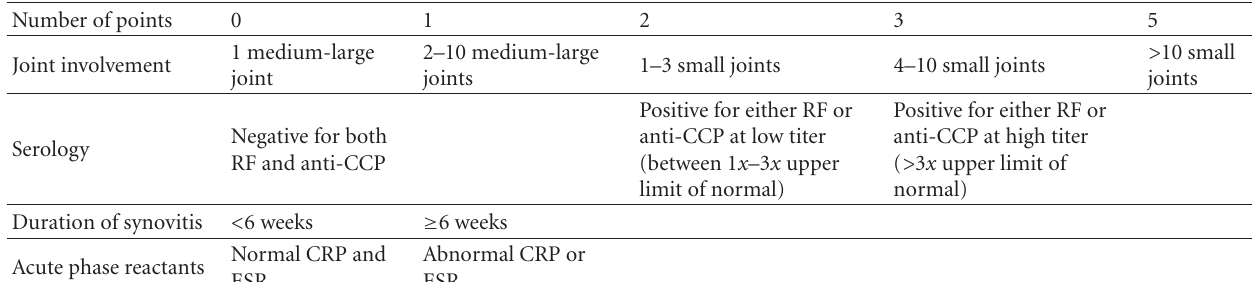
Table 3: 2010 ACR/EULAR scoring criteria for RA. The following table provides the scoring criteria for di ff erent domains of evaluation. For each cell in the table for which the patient satisfies the condition, the cell is scored by the number of points at the top of the column in which it is found. The patient’s score is the sum of the scores for the individual cells. Patients with a total score of 6 or more points are diagnosed as having